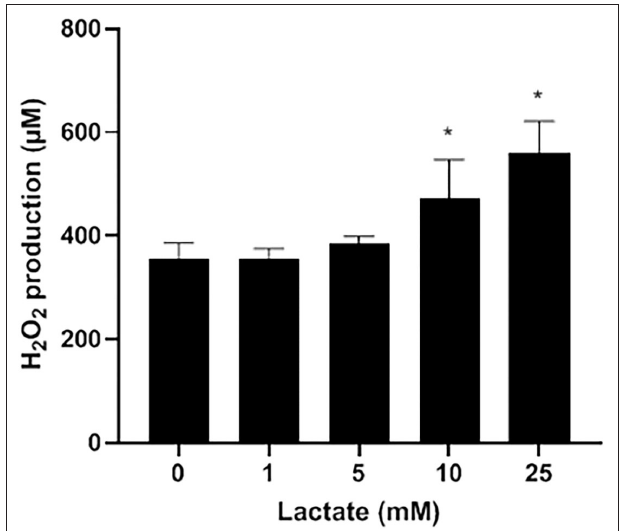
FIGURE 2 | Dose-dependent effect of exogenous lactate on the production of H 2 O 2 by S. pluranimalium 2N12. H 2 O 2 was quantified using a fluorimetric assay. Assays were performed in triplicate in two independent experiments, and the means ± SD were calculated. *Significantly different at p < 0.01 compared to the control (no